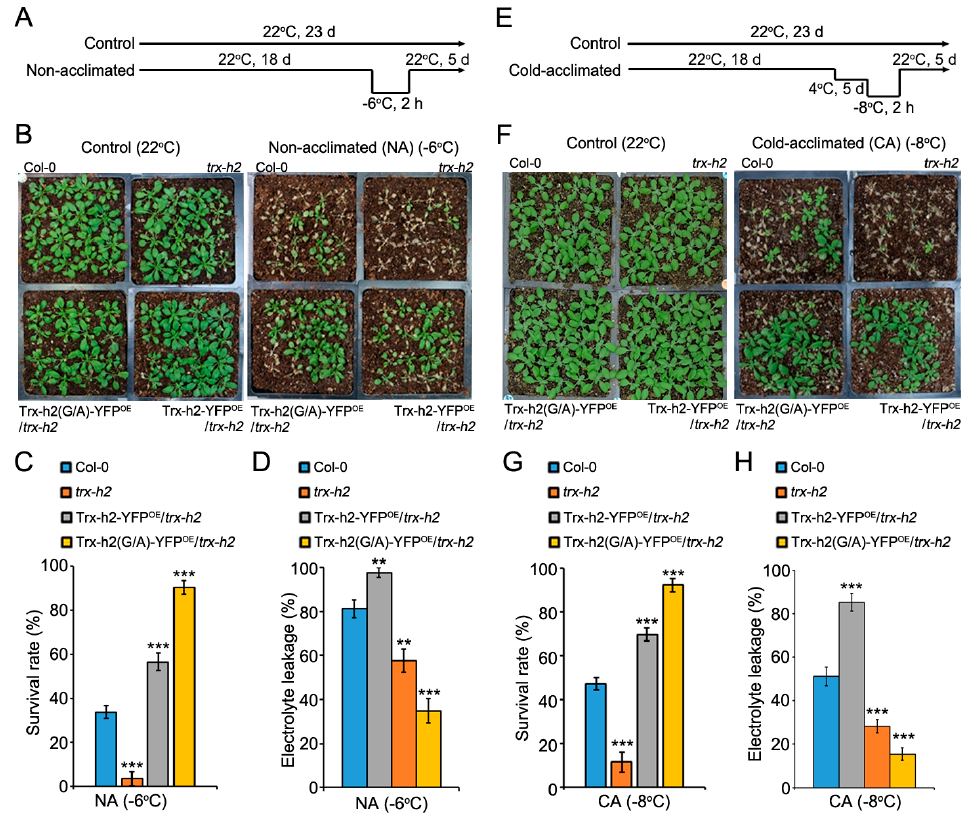
Figure 7. Comparison of the freezing tolerance of the NA and CA plants of Col-0, trx-h2 , Trx-h2-YFP OE / trx-h2 , and Trx-h2(G/A)-YFP OE / trx-h2 genotypes. ( A , E ) Freezing tolerance assay of plants in the NA treatment ( A ) and CA treatment ( E ). In the NA treatment, 18-day-old plants were placed in the freezing chamber at the desired temperature for 2 h. In the CA treatment, plants were pre-incubated at 4 ◦ C for 5 days before the freezing test. After exposing the plants to freezing stress, NA and CA plants were incubated at 22 ◦ C for 5 days for recovery. ( B – H ) Evaluation of the freezing stress tolerance of plants based on their recovery ( B , F ), survival rate ( C , G ), and electrolyte leakage ( D , H ). Data represent mean ± s.e.m. ( n = 3 biologically independent samples for survival rates, and n = 10 biologically independent samples for electrolyte leakage). Significant differences are indicated by asterisks (** p < 0.01, *** p < 0.001; Student’s t